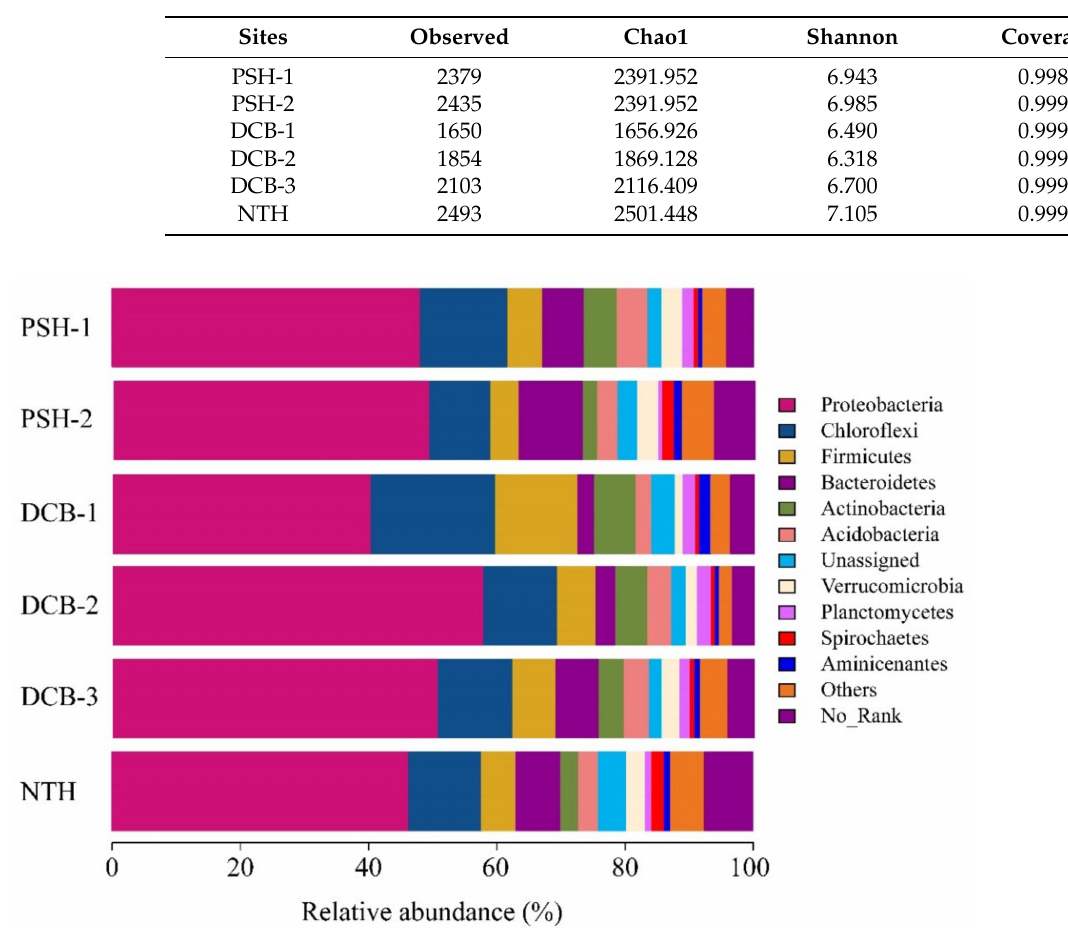
Table 2. The alpha diversity of the microbial sediment community.